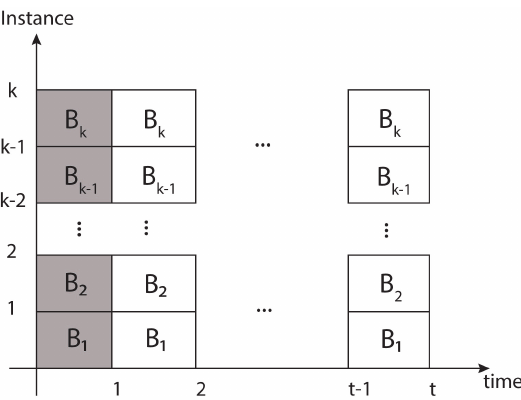
Figure 8. B i blocks are processed in parallel form during one given